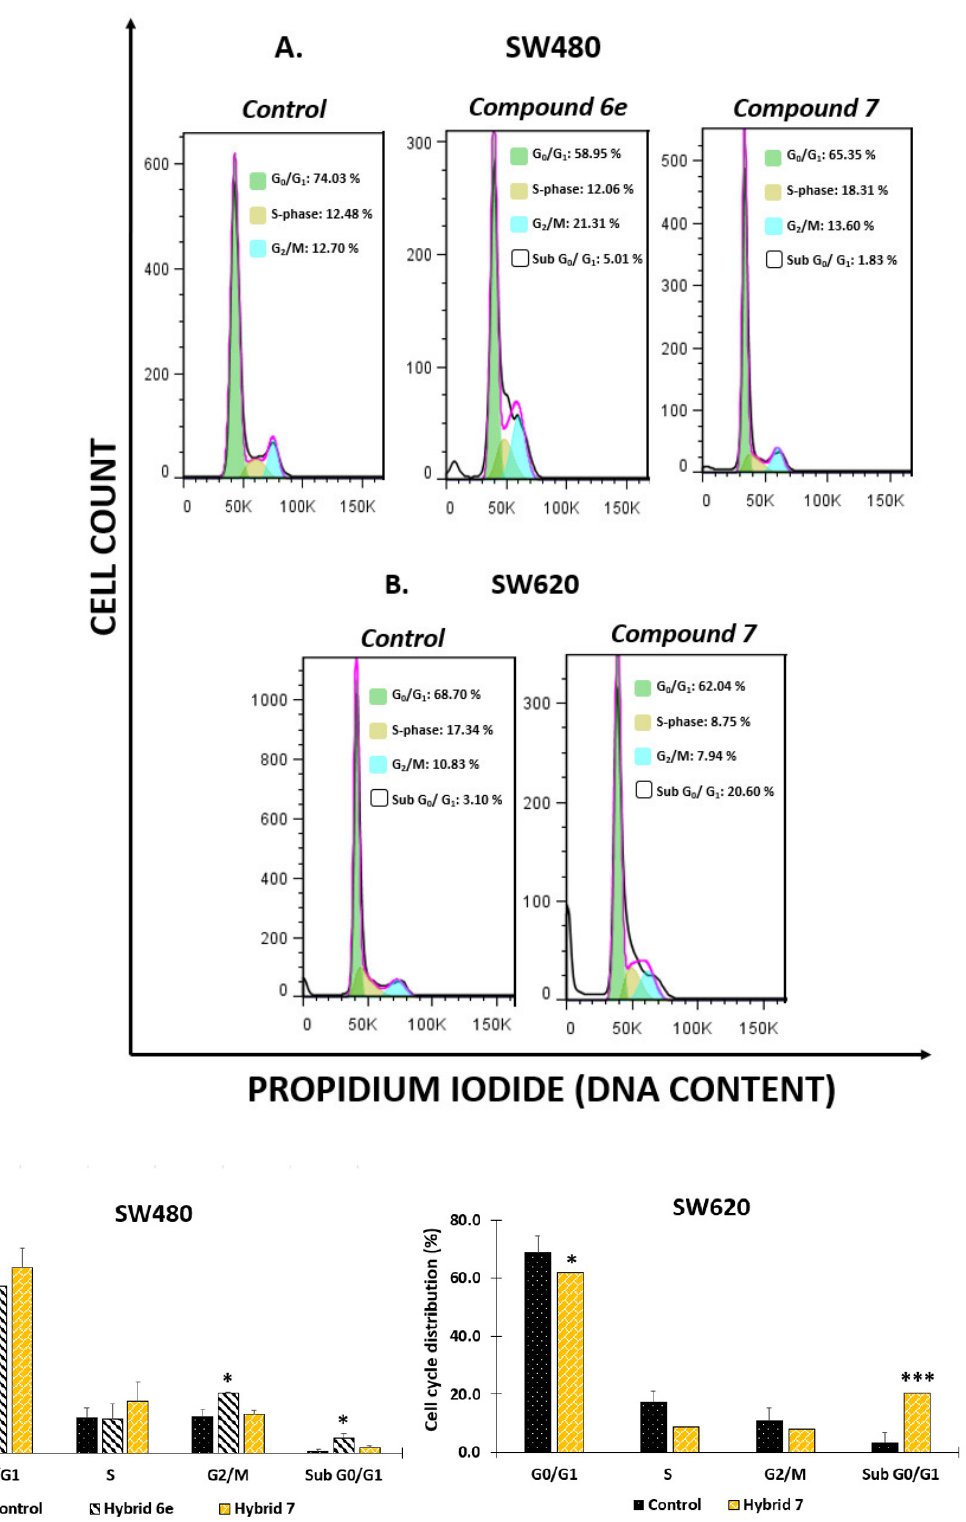
Figure 6. Effect of resveratrol/hydrazone hybrids on cell cycle distribution. ( A ) SW480 cells; ( B ) SW620 cells; ( C ) Statistical analysis of cell cycle phase distribution. One representative image of two independent experiments is shown. Data are presented as means ± SE of three independent tests. * p < 0.05 versus control, *** p < 0.001 versus control.